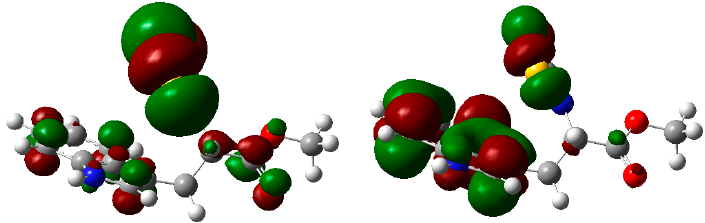
Figure 2. HOMO and LUMO for intermediate 9 (Isovalue of 0.02). White balls represent hydrogen atoms, gray balls represent carbon atoms, blue balls represent nitrogen atoms, red balls represents oxygen atoms, yellow balls represent sulfur atoms, dark red and green regions represent HOMO-LUMO orbitals.